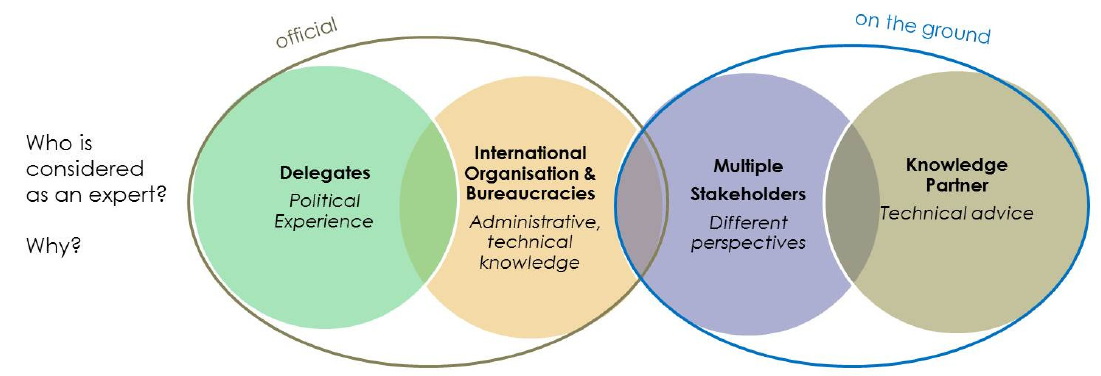
Figure 6. Expert Figure 6. Expert roles.